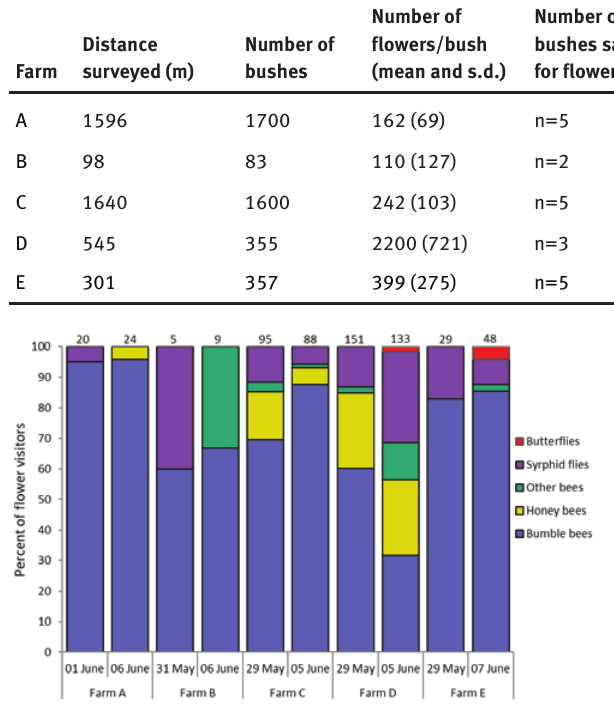
Distance Farm surveyed (m)